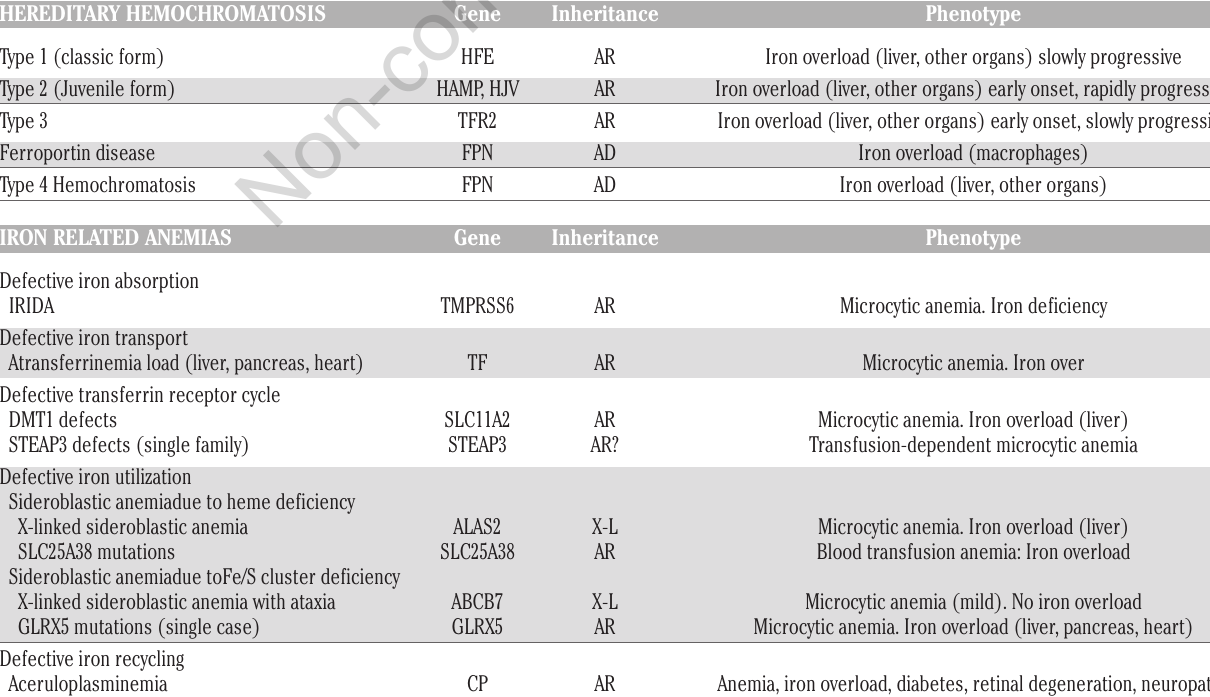
Table 1. Classification of inherited iron-related disorders HEREDITARY